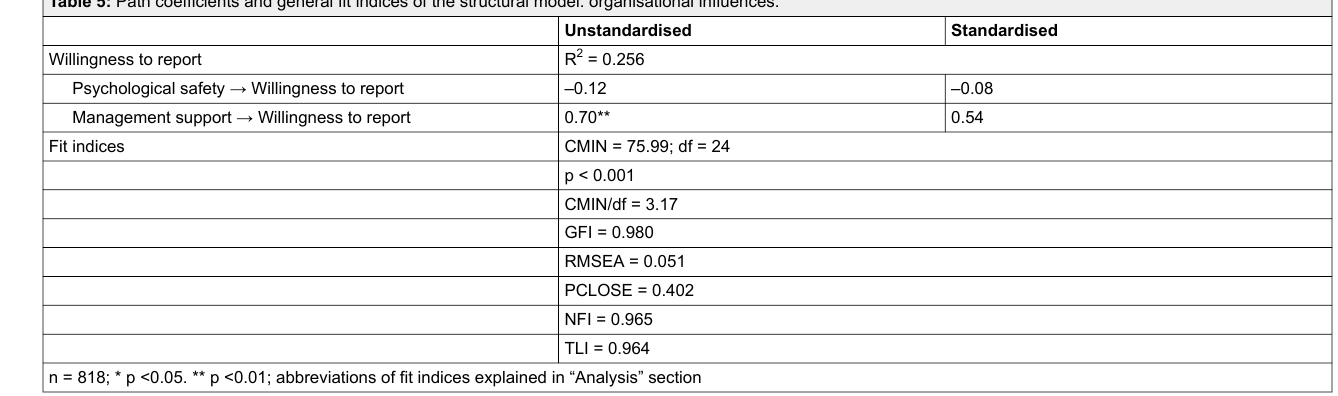
Unstandardised Standardised